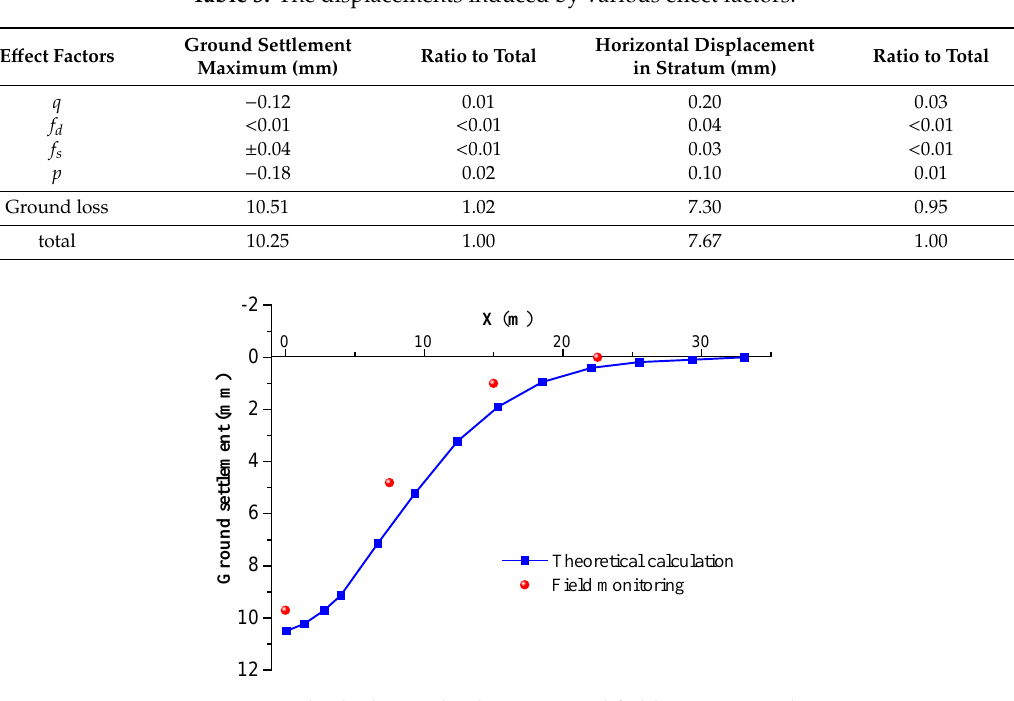
Table 3. The displacements induced by various effect factors.